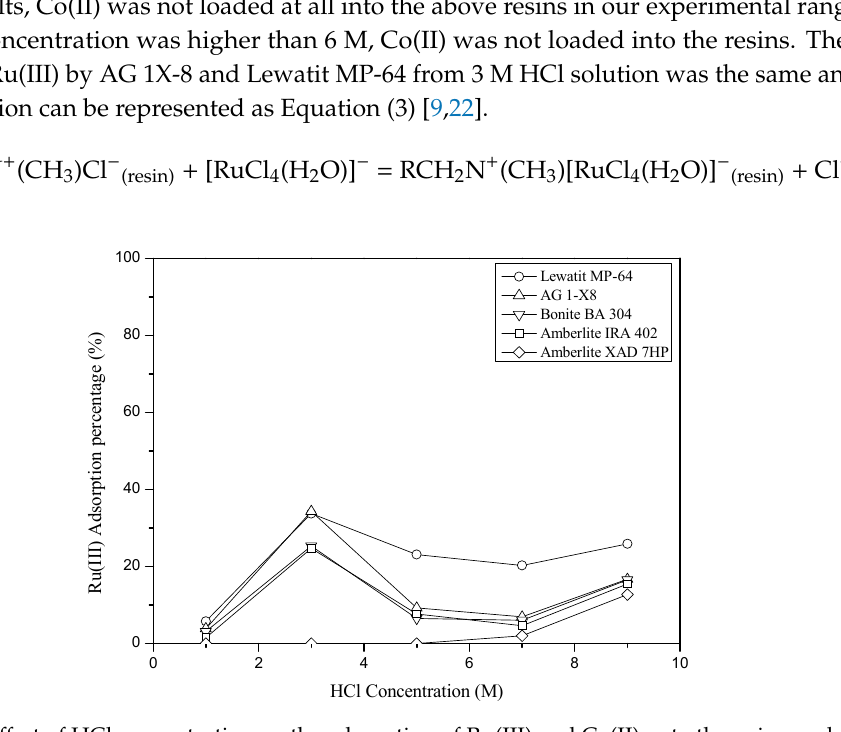
Figure 7. Effect of HCl concentration on the adsorption of Ru(III) and Co(II) onto the anion exchange resins. ([Time] = 6 h, [Resin] = 0.5 g/L, [Co(II)] = 100 mg/L and [Ru(III)] = 10 mg/L).